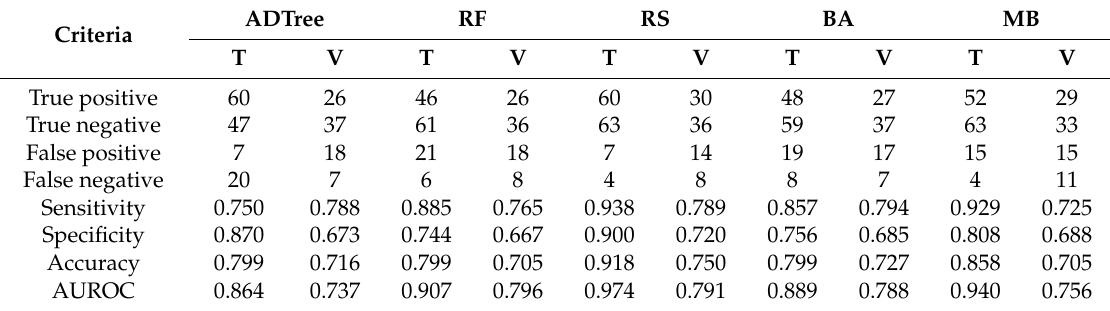
Table 6. Results of ensembles modeling by combination of 60%/40% and raster resolution of 10 m. ADTree Criteria